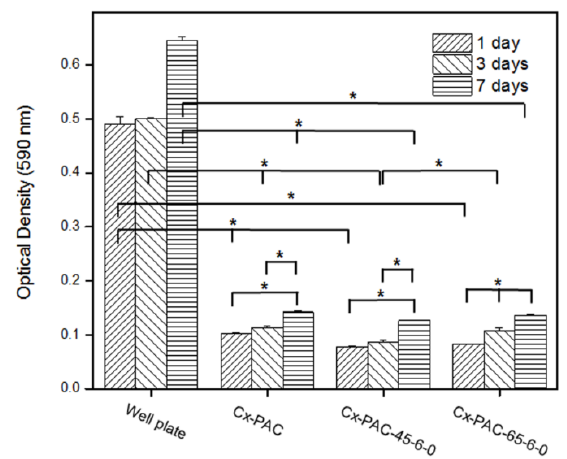
Figure 8. MTT assay of HUVECs cultured for one to seven days on well plates and Cx-PAC films after thermal treatment at 4 °C and 65 °C (* p < 0.001).